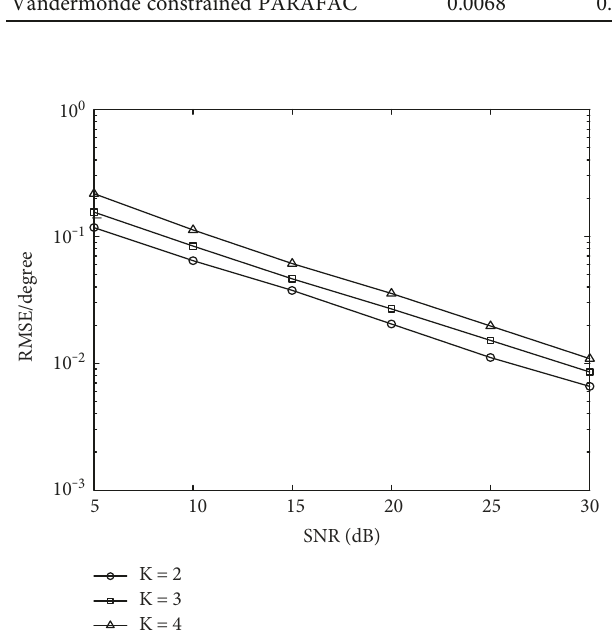
Figure 7: RMSE performance of the proposed method for di ff erent number of sources K ( M = 8 , N = 300